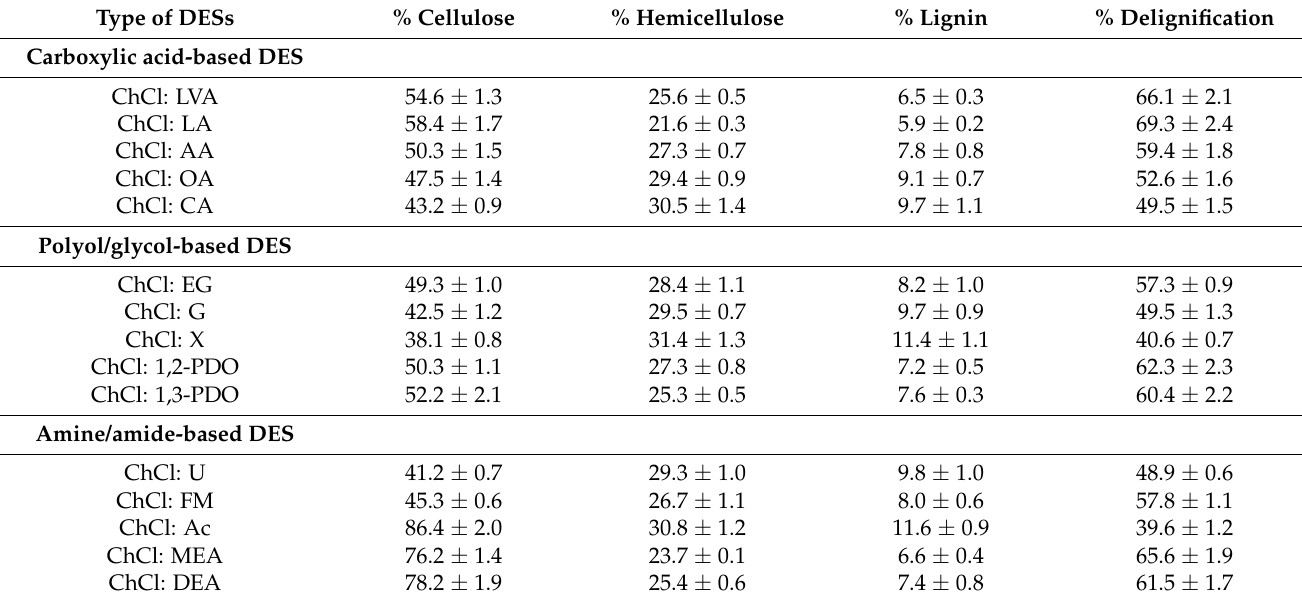
Table 3. Characterization of Atriplex crassifolia after pretreatment from various deep eutectic